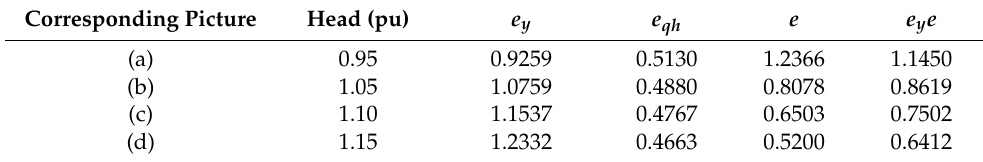
Figure 7. Stability regions at various parameters: ( a , b ) the effect of speed and opening parameters; ( c ) the stability domain variation curves of different heads at the design opening; ( d ) the effect of the time constant of the converter. Table 1. Transfer coefficients of the pump-turbine at different heads (opening at